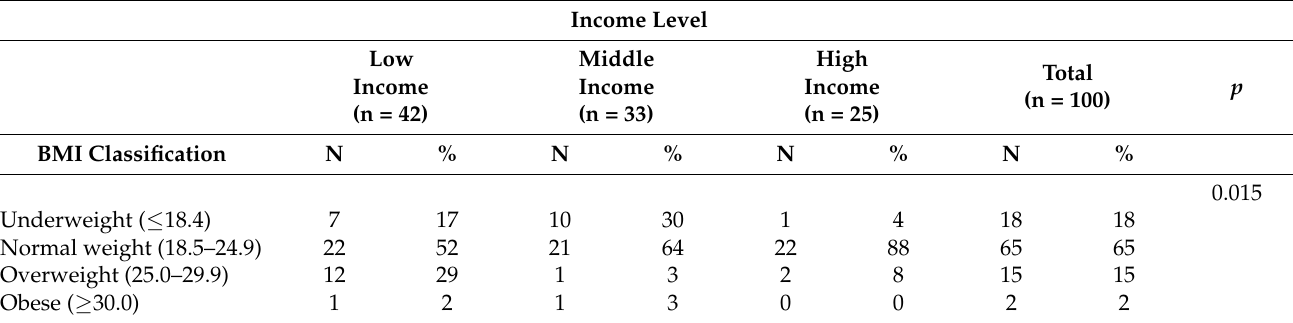
Table 5. Classification of BMI according to income